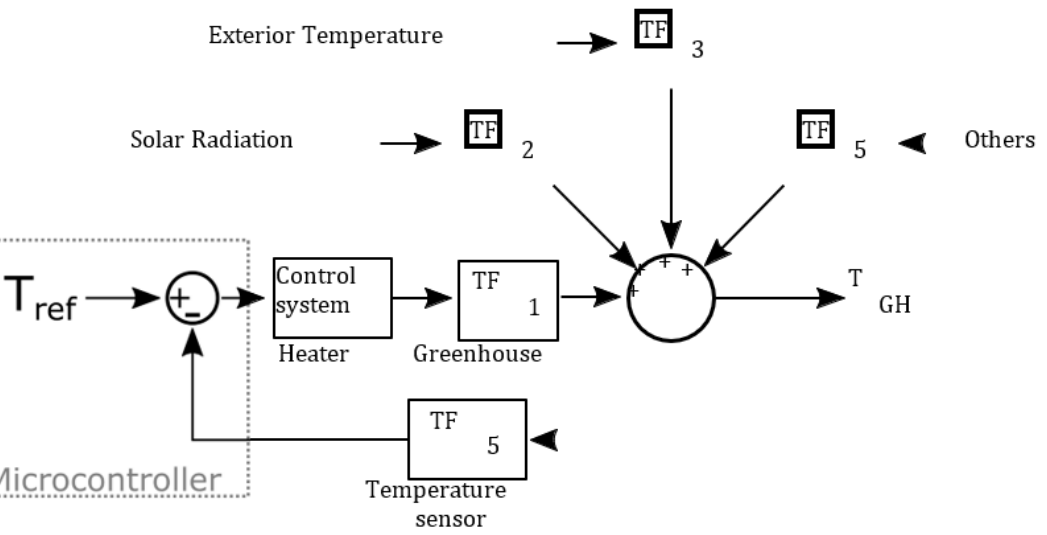
Figure 21. System-identified transfer functions from models for thermal control applications. (Based on [8]).